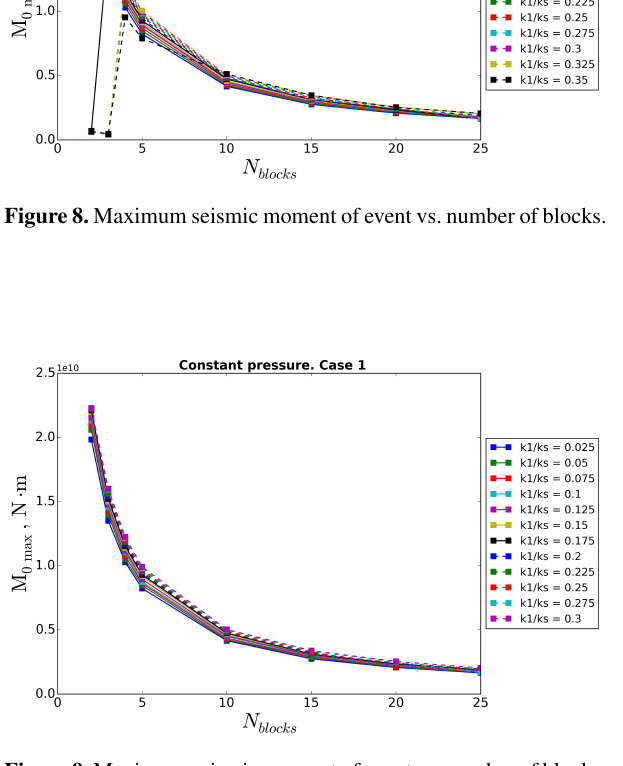
Figure 6. Cumulative number of events vs. number of blocks.